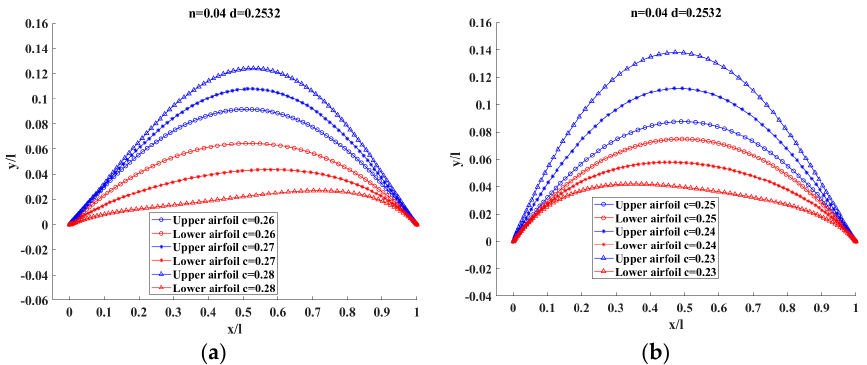
Figure 7. Influence of the imaginary axis translation parameter on the airfoil shape. ( a ) Curvature when the value of c is greater than the value of d ; ( b ) Curvature when the value of c is less than the value of d .